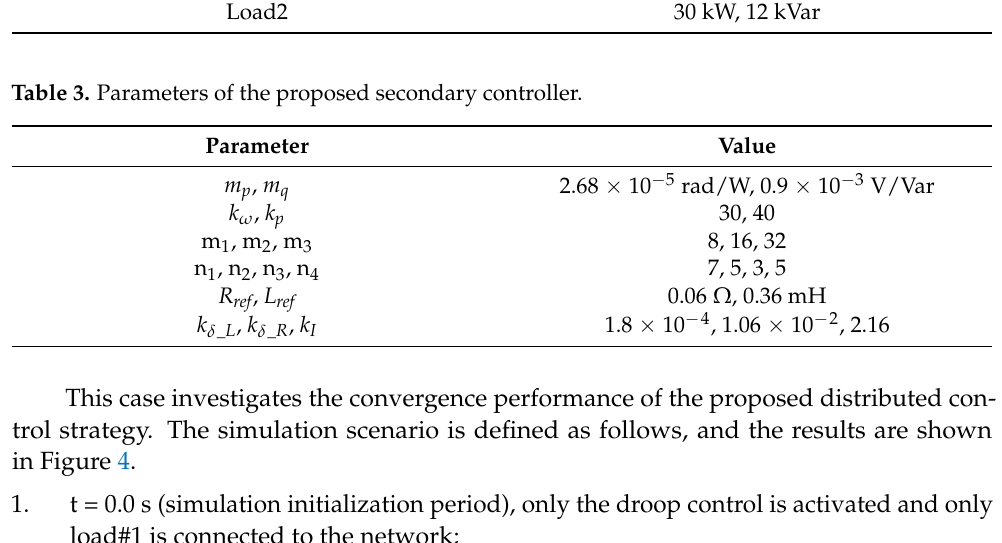
Table 2. Electrical parameters.